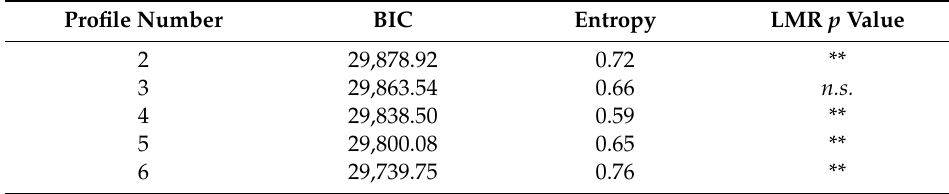
Table 2. Fit indices for the six estimated solutions of job demands and job control profiles. Profile Number BIC Entropy LMR p Value 2 29,878.92